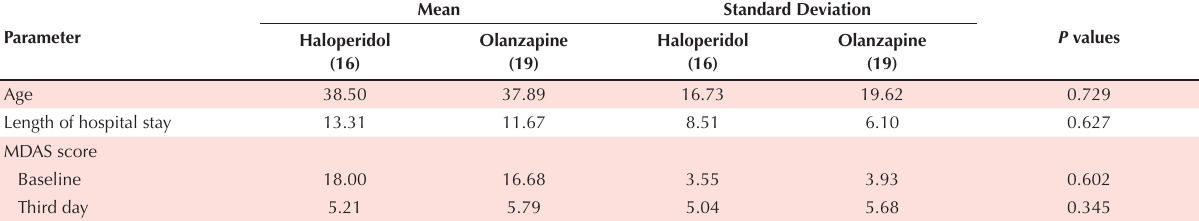
Table 2. Demographic data (quantitative) and MDAS rating in the study groups